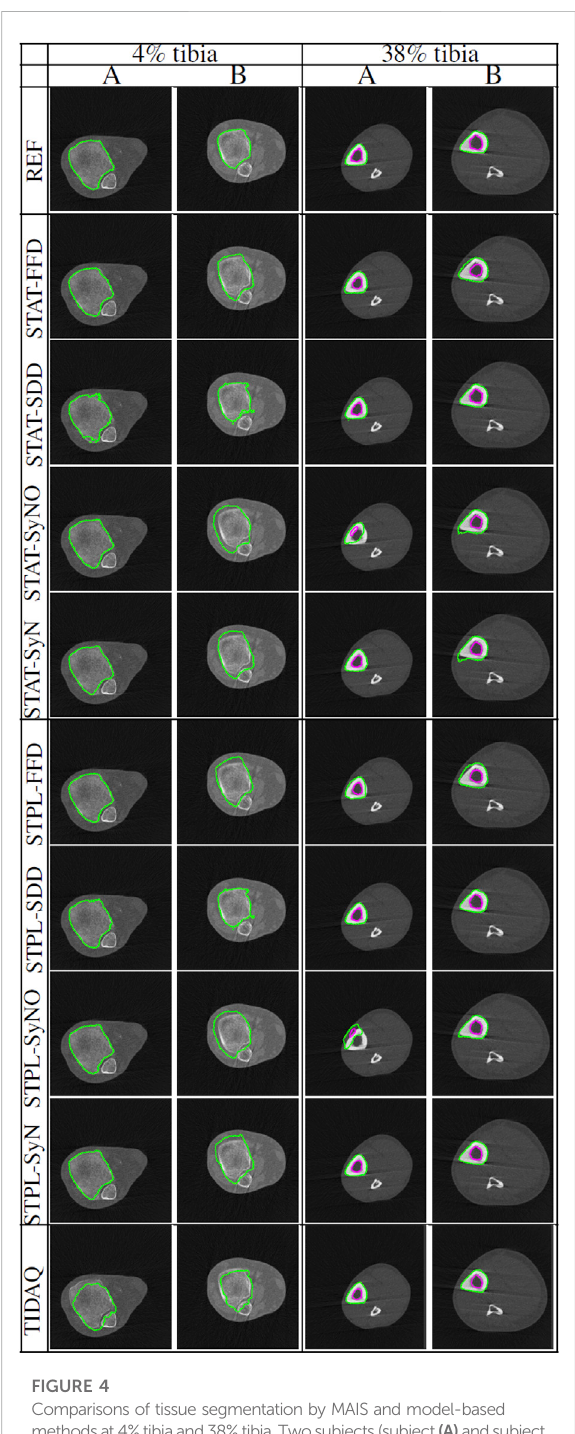
FIGURE 4 Comparisons of tissue segmentation by MAIS and model-based methodsat4%tibiaand38%tibia.Twosubjects(subject (A) andsubject (B) ) are selected at each tibial site to demonstrate the performance of the compared methods. At 4% the trabecular bone is delineated by the green contour, and at 38% the cortical bone and the trabecular bone are delineated by the green and magenta contours,